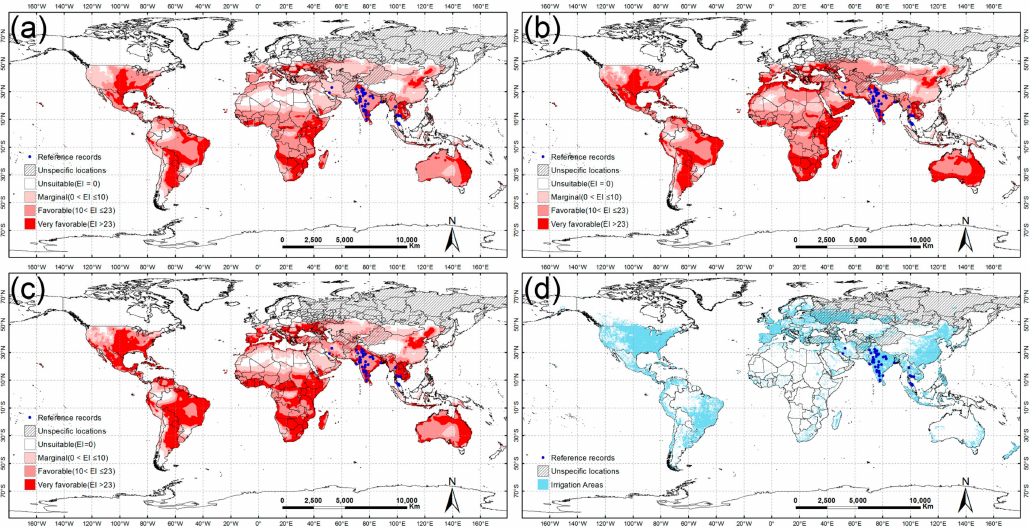
Figure 1. Potential global distribution of Carpomya vesuviana under the historical climate. ( a ) Projected global distribution of C. vesuviana assuming natural rainfall. ( b ) Projected global distribution of C. vesuviana with irrigation I. ( c ) Projected global distribution of C. vesuviana with irrigation II. ( d ) Global map of irrigation areas. The known current distribution is shown as reference records (blue dots) or as ambiguous locations (cross-hatched regions), which are indeterminate regions where specific record location(s) is / are unknown. White indicates unsuitable areas (EI (eco-climatic index) = 0); light pink indicates areas of marginal suitability (0 < EI ≤ 10); medium pink indicates areas of favorable suitability (10 < EI ≤ 23); red indicates areas of very favorable suitability (EI ≥